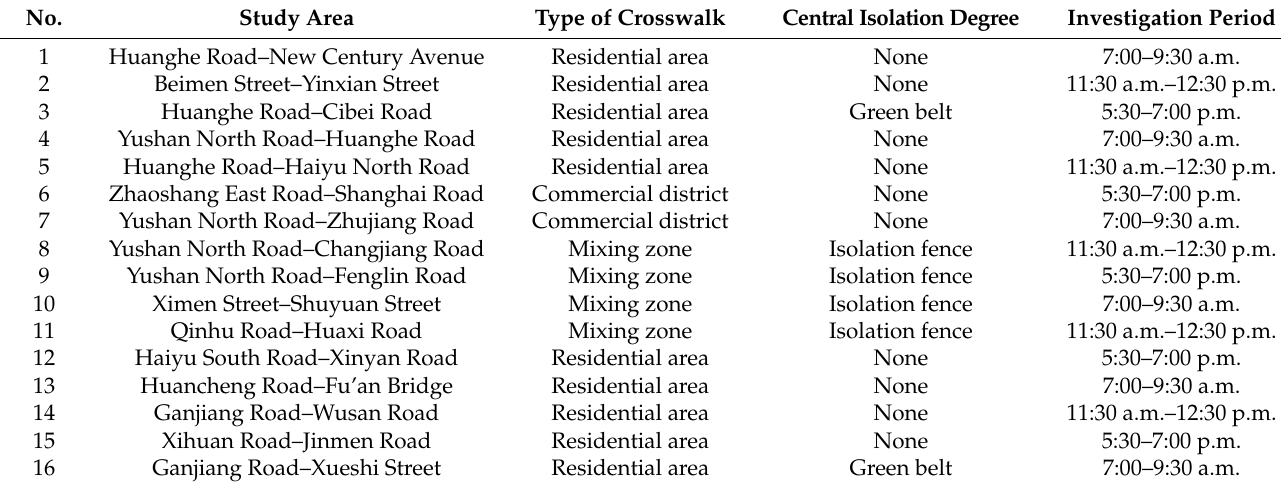
Table A1. Study area of pedestrian